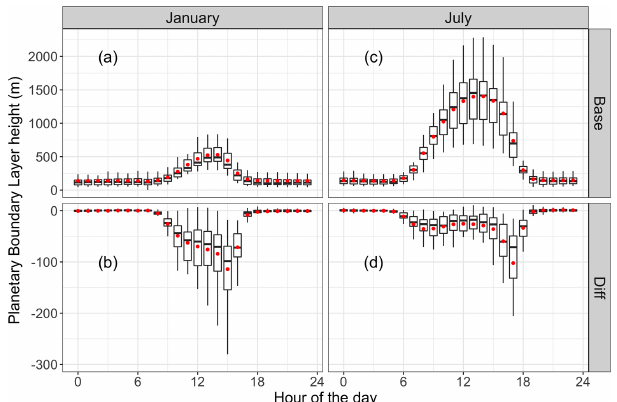
Figure 3. Diurnal variances of planetary boundary layer (PBL) height (a, c) and the impact of ADEs on PBL height (b, d) , in Jan- uary and July 2013. The central rectangle spans the first quartile to the third quartile. The segment and red dot inside the rectangle show the median and mean value, respectively. The whiskers above and below the box extend to the highest and lowest values.